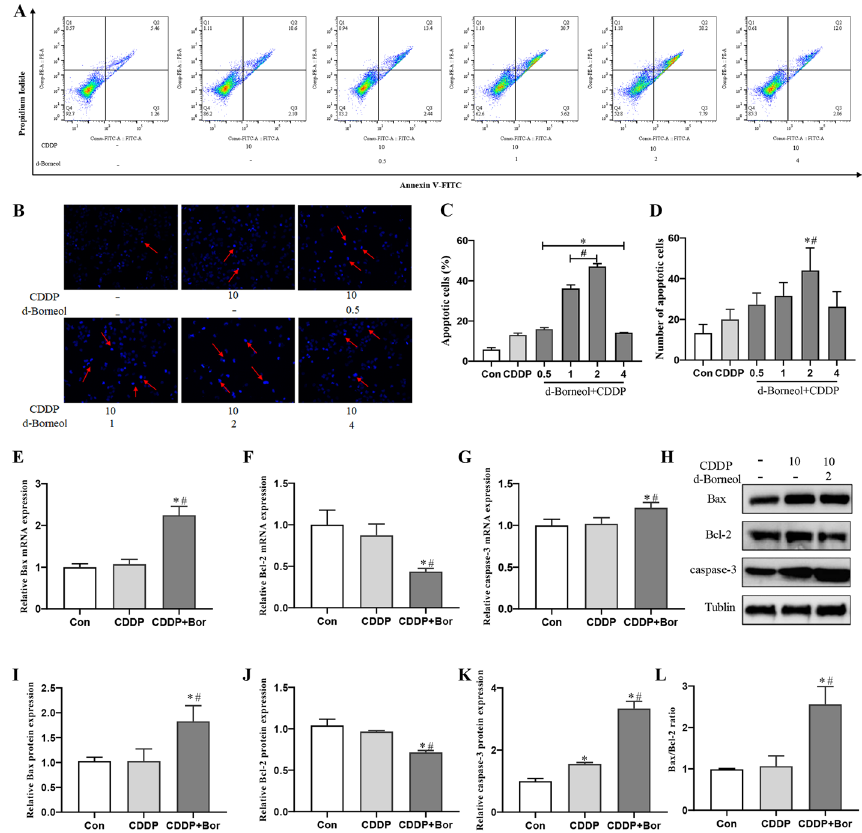
Fig. 2 d-Borneol induced cell apoptosis in H460/CDDP cells. A , C Flow cytometry showing the apoptotic cell percentages in each group; B , D representative picture of H460/CDDP cells Hoechst staining in each group and quantitative analysis; E – G mRNA expression of Bax ( E ), Bcl-2 ( F ), and caspase-3 ( G ); H – K protein expression of Bax, Bcl-2, and caspase-3 and their relative statistical analysis; l ratio of Bax/Bcl-2. All data are presented as mean SD ( n 3, * P < 0.05, compared with Con; # P < 0.05, compared with CDDP ± =